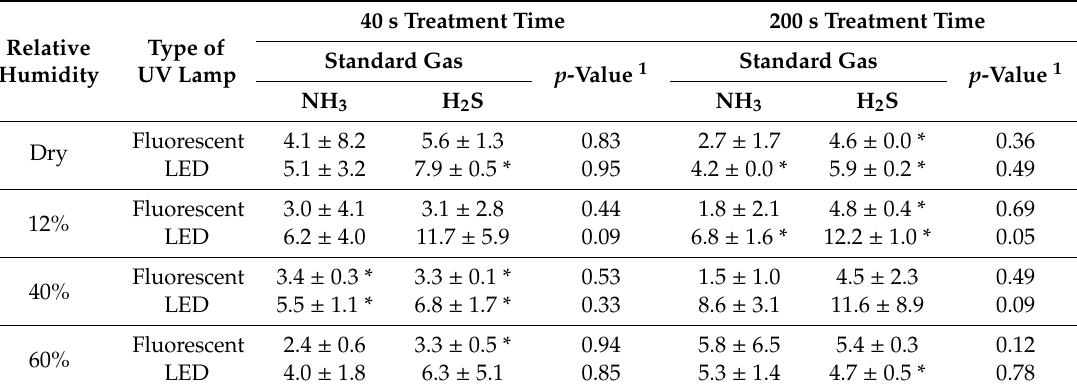
Table 3. The mitigation of N 2 O during photocatalysis of NH 3 and H 2 S standard gases.